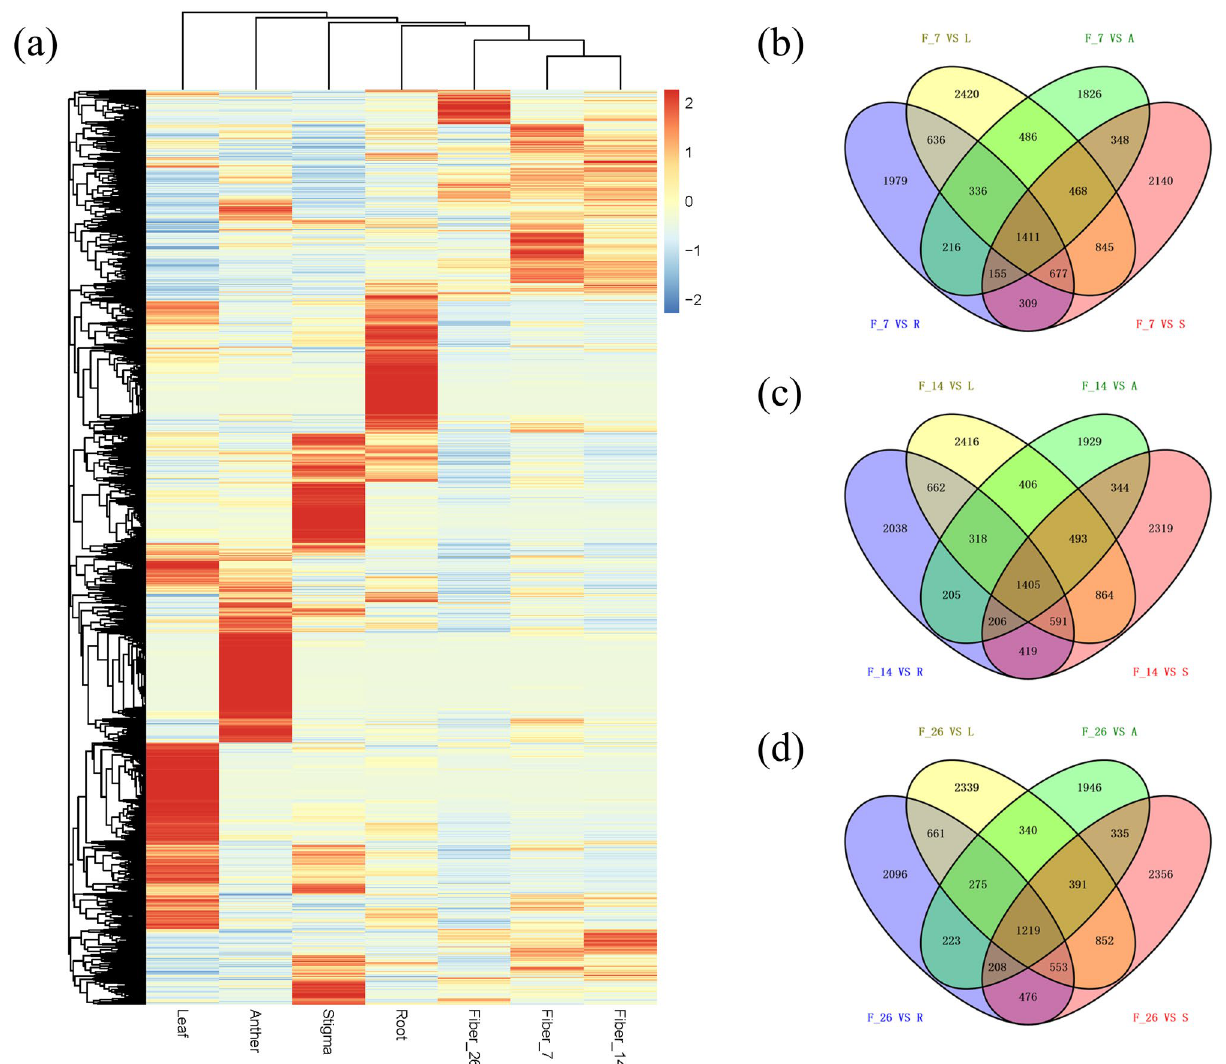
Figure 4. DEGs identified in seven different tissues from comparisons between fiber and nonfiber tissues. ( a ) Heatmap of DEGs (p value < 0.05, |Log2(Fold Change)| ≥ 2 at one sampling point); ( b ): Venn diagram analysis of the DEGs in 7 DPA fiber and nonfiber tissues; ( c ): Venn diagram analysis of the DEGs in 14 DPA fiber and nonfiber tissues; ( d ): Venn diagram analysis of the DEGs in 26 DPA fiber and nonfiber tissues. A anther, L leaf, R root, S stigma, F_7 7 DPA fiber, F_14 14 DPA fiber, F_26 26 DPA